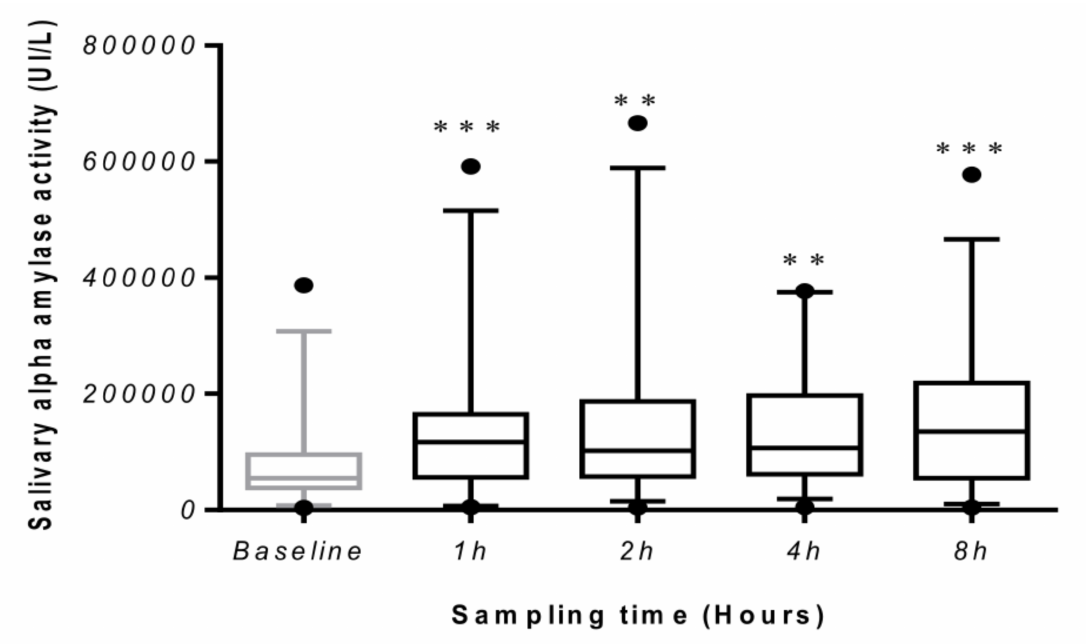
Figure 5. Salivary alpha amylase changes box plots. The boxes (25–75th percentiles) show the median concentrations of salivary marker (line within the box) and whisker plots represent the minimum (5th percentiles) and maximum values (95th percentiles). ** p < 0.01 and *** p < 0.001 compared to baseline values. N = 31.